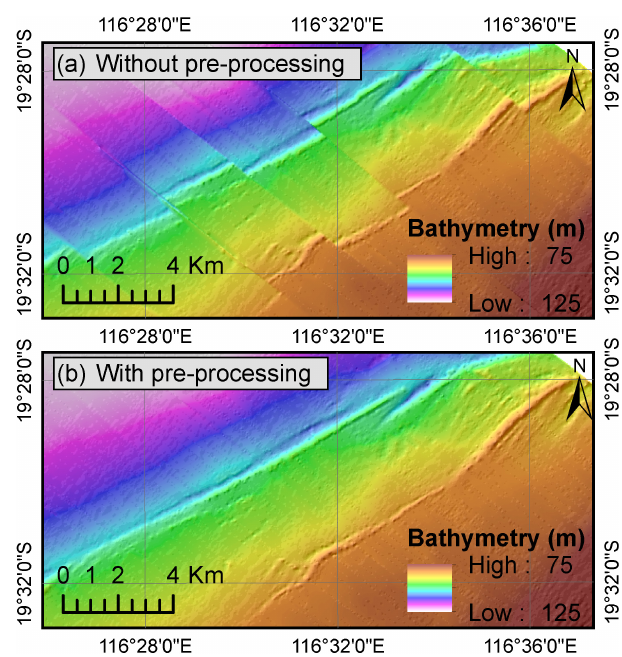
Figure 5. Comparison of the navigation-derived bathymetry gen- erated using raw navigation files (a) or filtered (i.e. pre-processed) navigation files (b) from Demeter 3D survey. With raw navigation files, depth measurements are sometimes associated with the coor- dinates of the seismic receivers which can be located hundreds of metres behind the vessel, hence creating a “banded” pattern. During the filtering process, depth measurements were re-aligned with the vessel position. For data sources, see Sect.